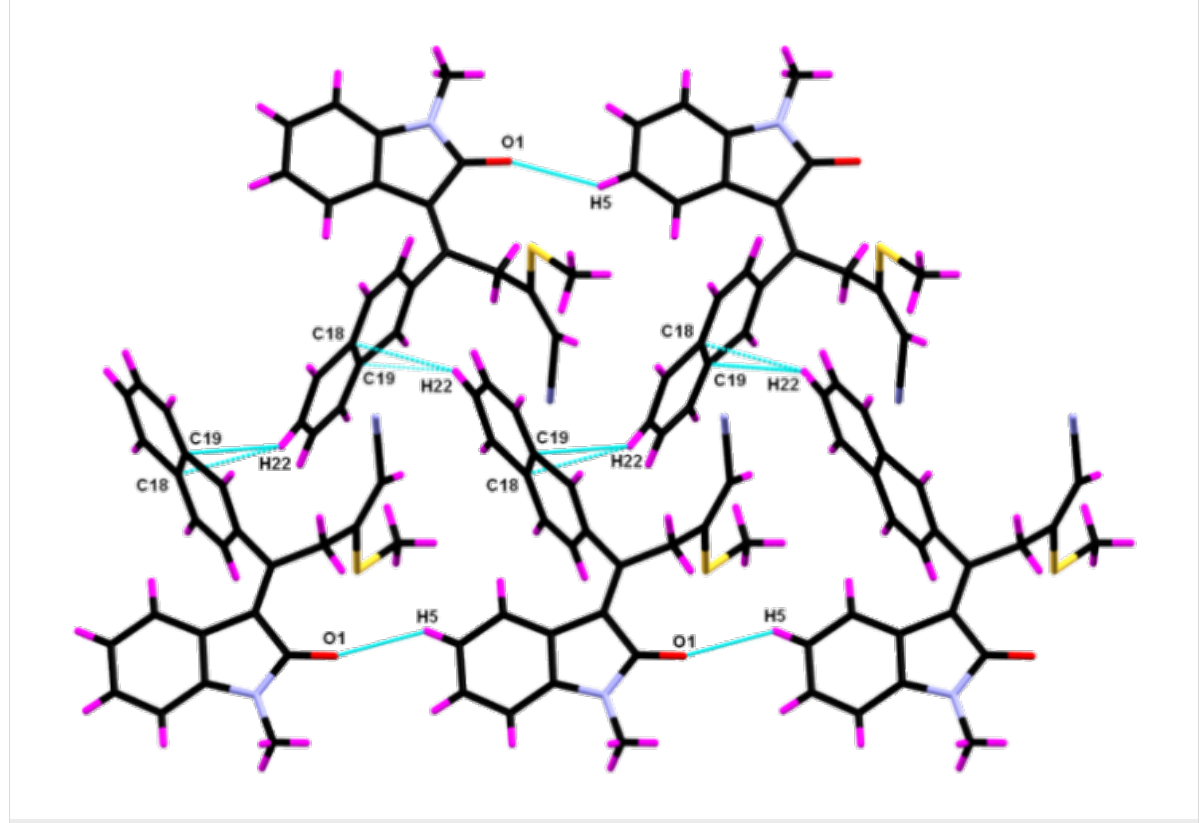
Figure 5: Supramolecular chain of 8yc bound by weak C − H … O and Ar-H … π intermolecular interactions (symm. op. 2 − x , − 1/2 + y ,3/2 − z ).